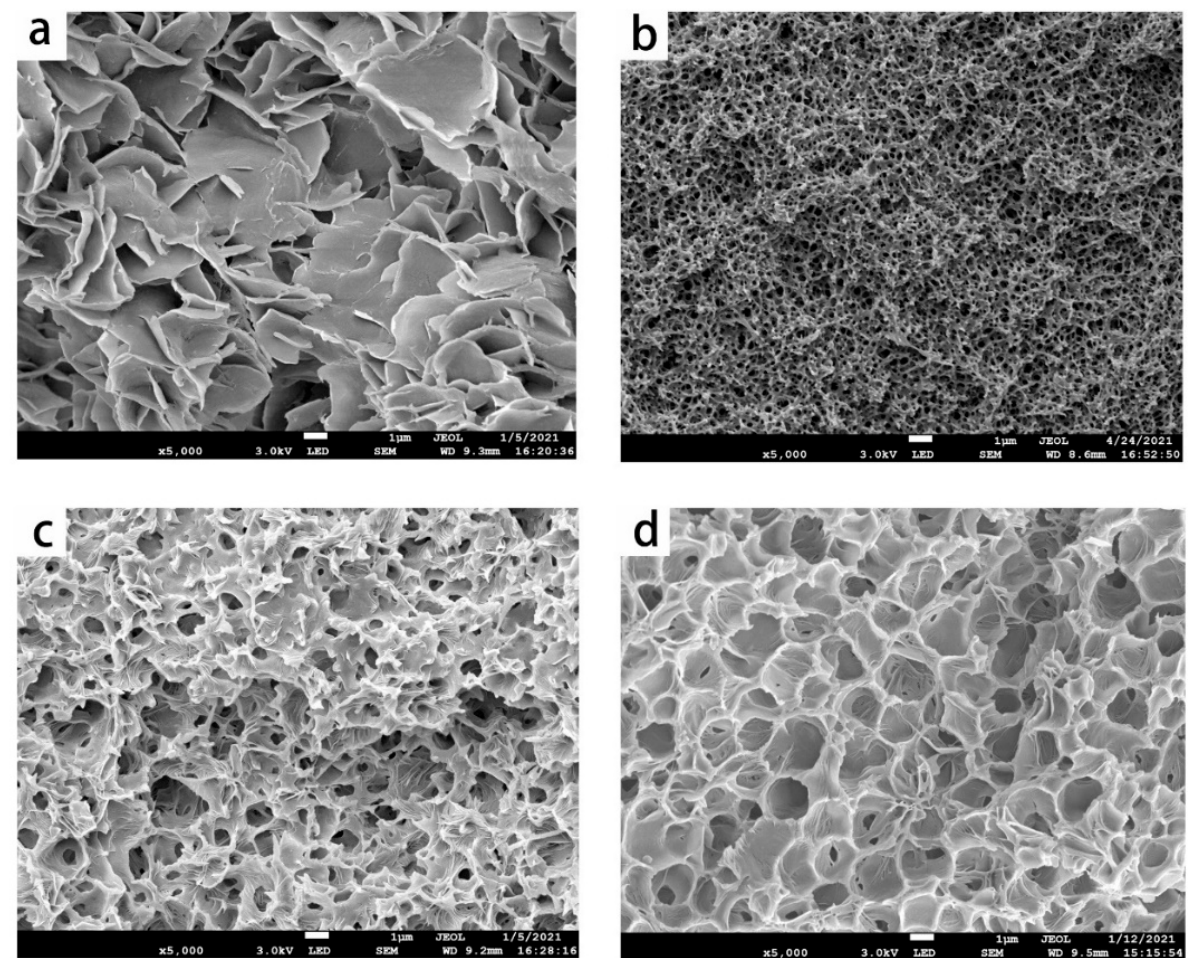
Figure 2. The cross-section structures of the PMP piece membranes prepared by different fatty acids with a PMP concentration of 30 wt%: ( a – d ) represent the fatty acid of LA, MA, PA and SA, respectively.